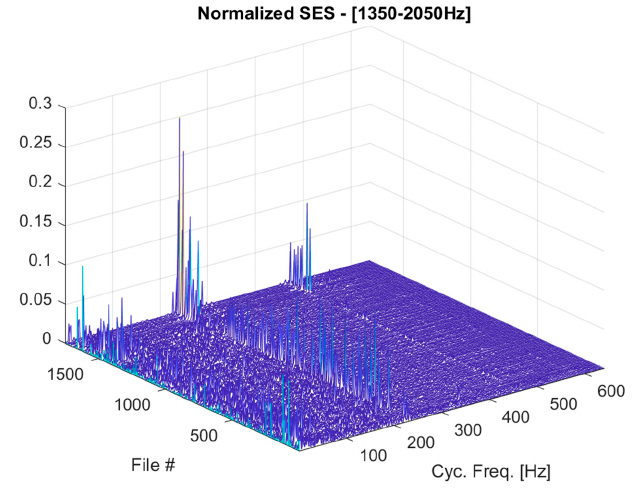
Figure 12. Values of the normalized SES for the different data sets, first frequency band—right TB. The axis on the left of the base plane is relative to the vibration records sorted in chronological order.